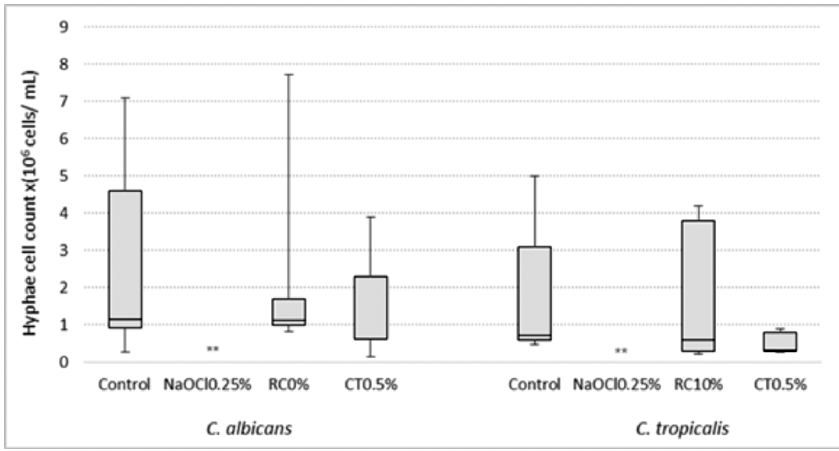
Figure 5- Comparison hyphae cell count (x10 6 cells/ mL) of Candida spp. after immersion of the specimens in the disinfectant solutions and water (Control)